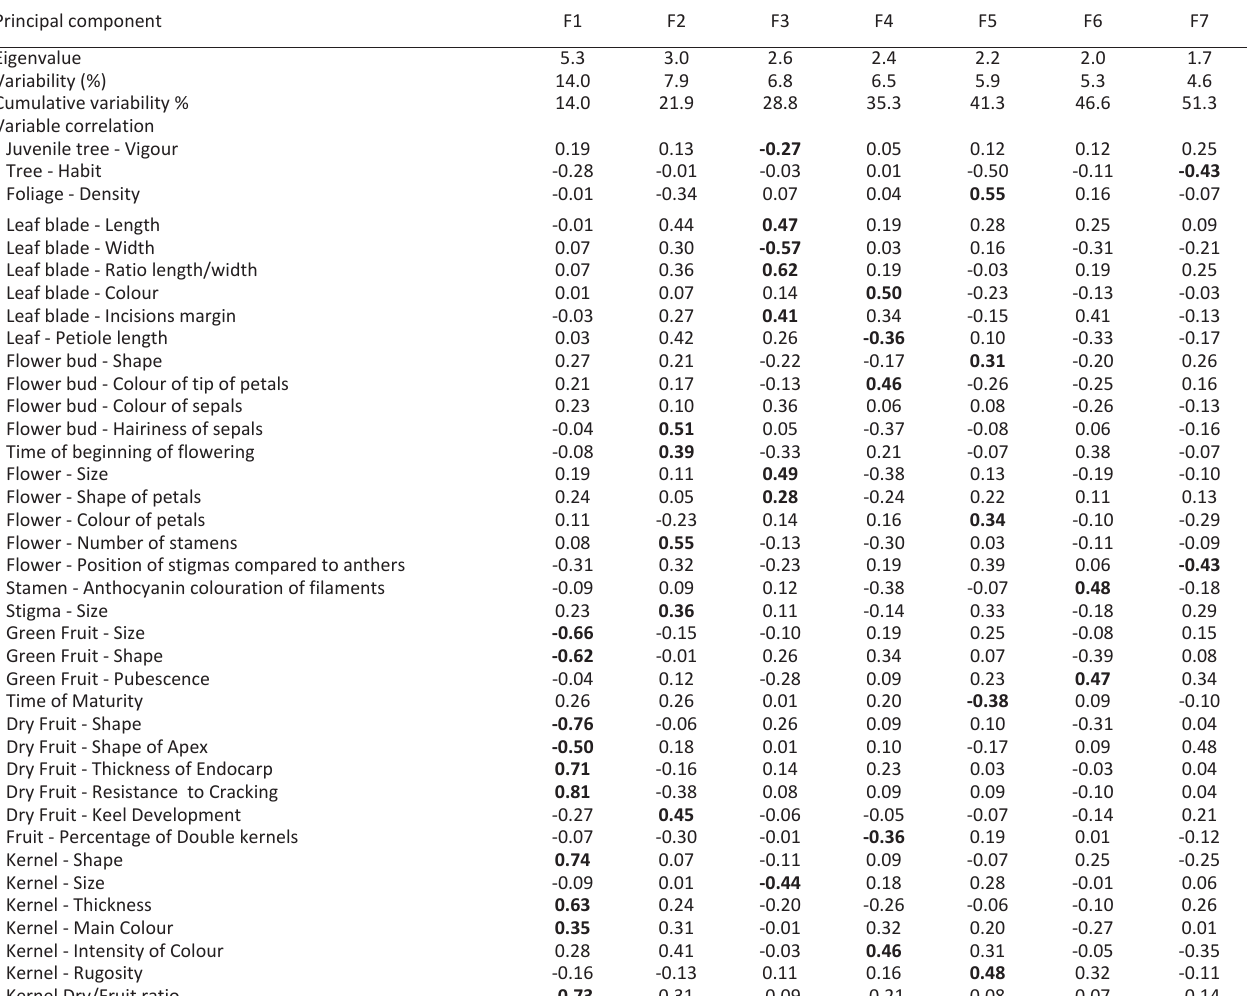
Table 4 - Eigenvalues, expressed variability and correlations of the first seven Principal Components (accounting for 51.3% of variability) obtained from the whole accession/variable data set. The highest absolute correlation of each variable is in